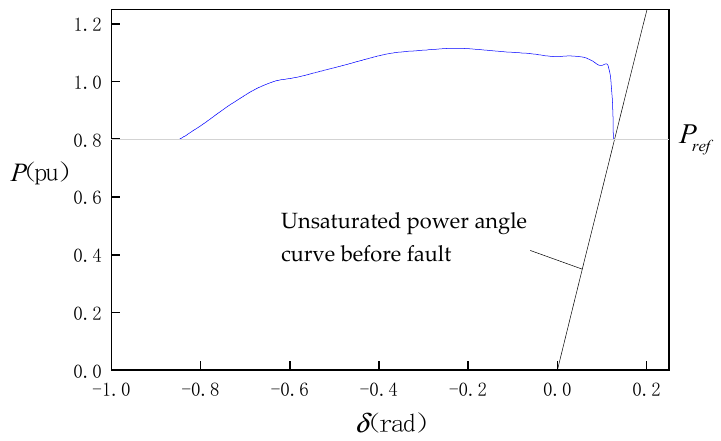
Figure 12. Simulation results of medium voltage sag while X Σ is 0.16 pu.